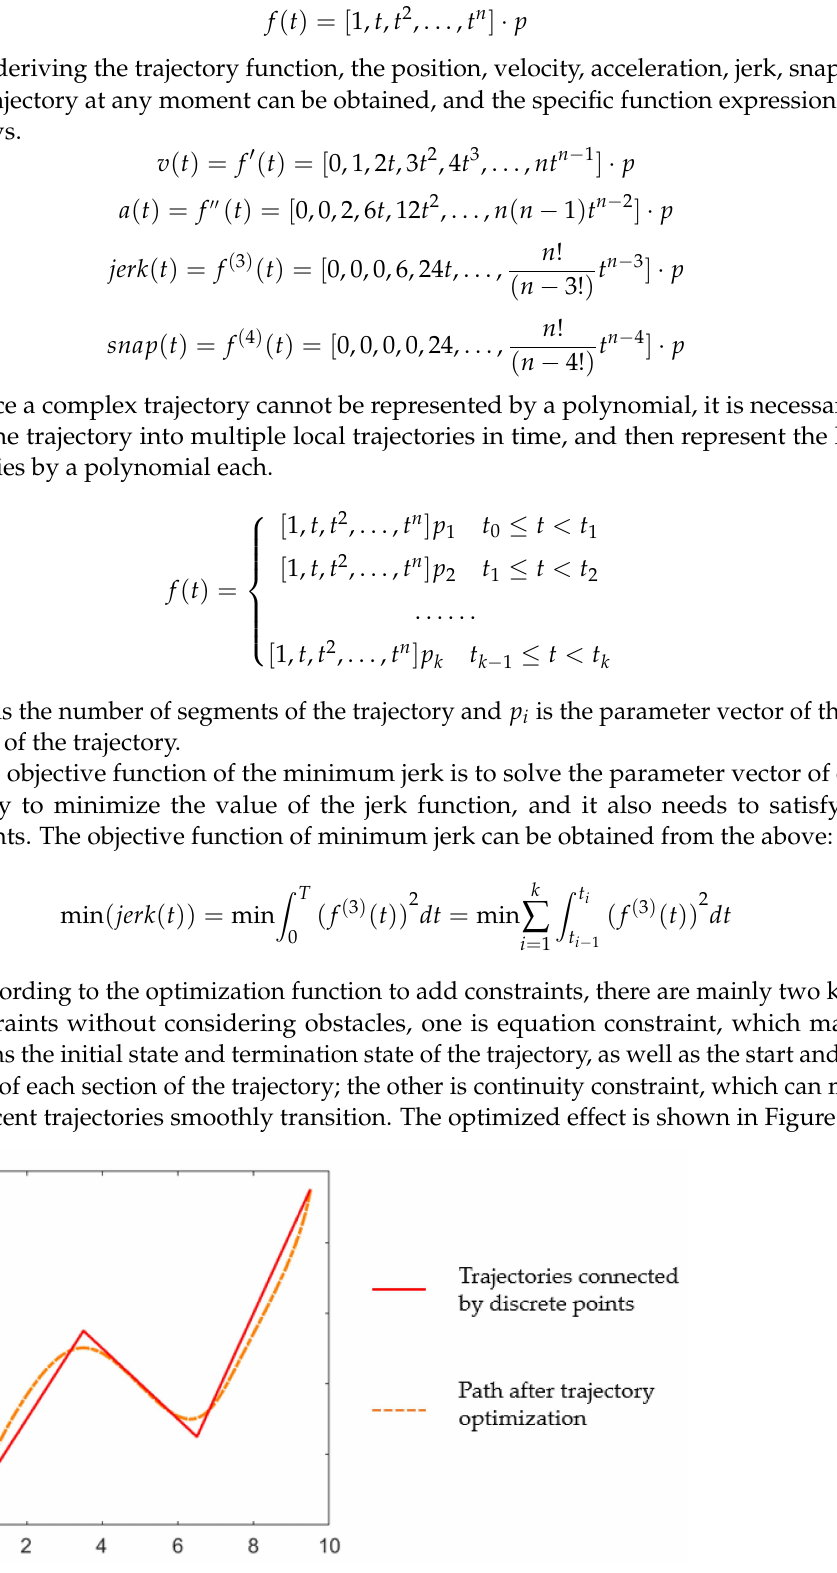
Figure 4. Trajectory optimization effect